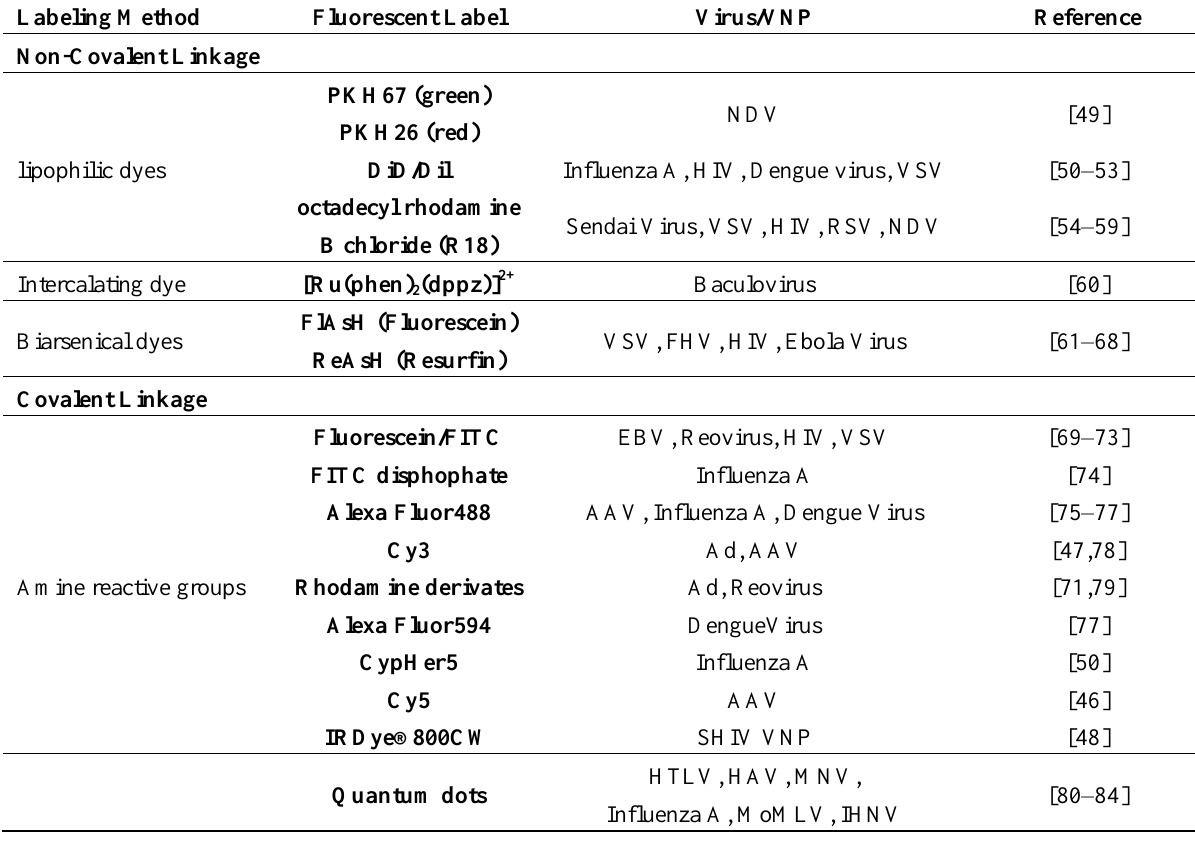
Table 1. Fluorescent labels applied for chemical labeling of viral